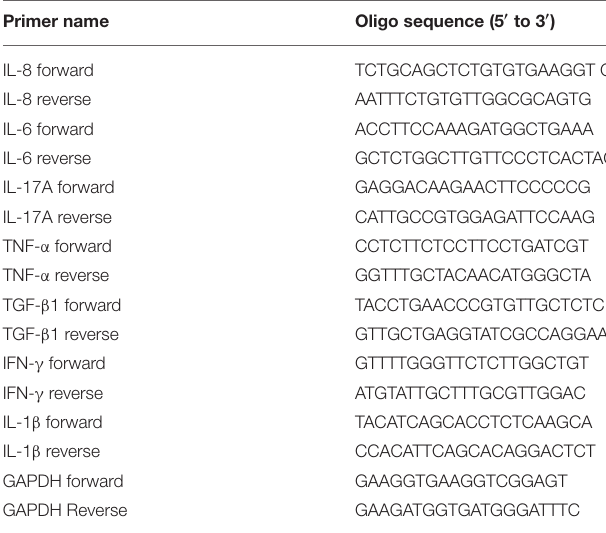
TABLE 2 | Forward and reverse primers inflammatory markers and their oligo sequences. Primer